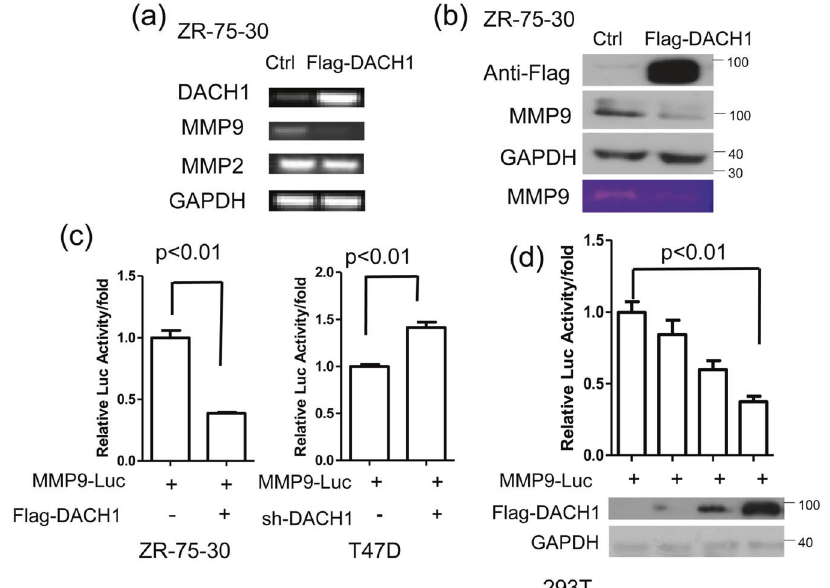
Fig. 2 DACH1 down-regulates the level of MMP9. a ZR-75-30 cells were transfected with Flag-DACH1 or control vector, and then subjected to the analysis of MMP9 and MMP2 expression by RT-PCR. b Western blot assay evaluating the protein level of MMP9 in ZR-75-30 cells transfected with Flag-DACH1 or control vector (the fi rst three lines). The medium from this assay was subjected to gelatin zymography (the last line). c Breast cancer cells were transfected with MMP-Luc together with or without Flag-DACH1 (left) or sh-DACH1 (right). Luciferase activity was measured 24 h after transfection. d HEK293T cells were transfected with MMP-Luc along with 0, 200, 400, 600 ng Flag-DACH1, and the luciferase activity was measured 24 h after transfection. There were three independent experiments with three parallel wells each. The data are representative of three independent experiments. Data are presented as means ± SD ( P < 0.05, signi fi cant; ns, not signi fi